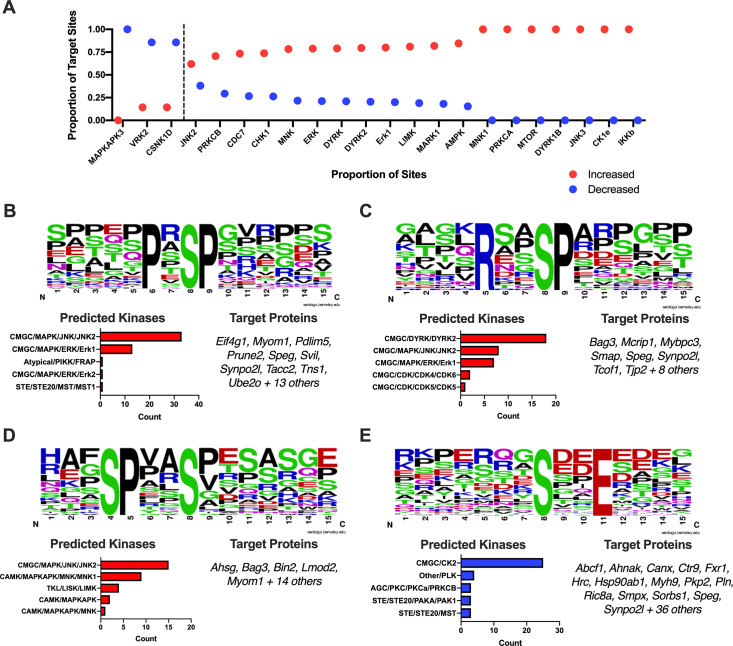
Bioinformatic kinase prediction uncovers stimulation of JNK and DYRK2 and suppression CK2 activities.A, Kinases with significant proportions (Chi-squared p-value < 0.05) of differentially expressed phospho-sites. B, Logo of enriched motif “PxSpP” (top) with bar graph of the number of predicted kinase sites (bottom left) and list of target proteins (bottom right). C, Logo of enriched motif “RxxSpP” (top) with bar graph of the number of predicted kinase sites (bottom left) and list of target proteins (bottom right). D, Logo of enriched motif “SPxxSp” (top) with bar graph of the number of predicted kinase sites (bottom left) and list of target proteins (bottom right). E, Logo of enriched motif “SpxxE” (top) with bar graph of the number of predicted kinase sites (bottom left) and list of target proteins (bottom right).